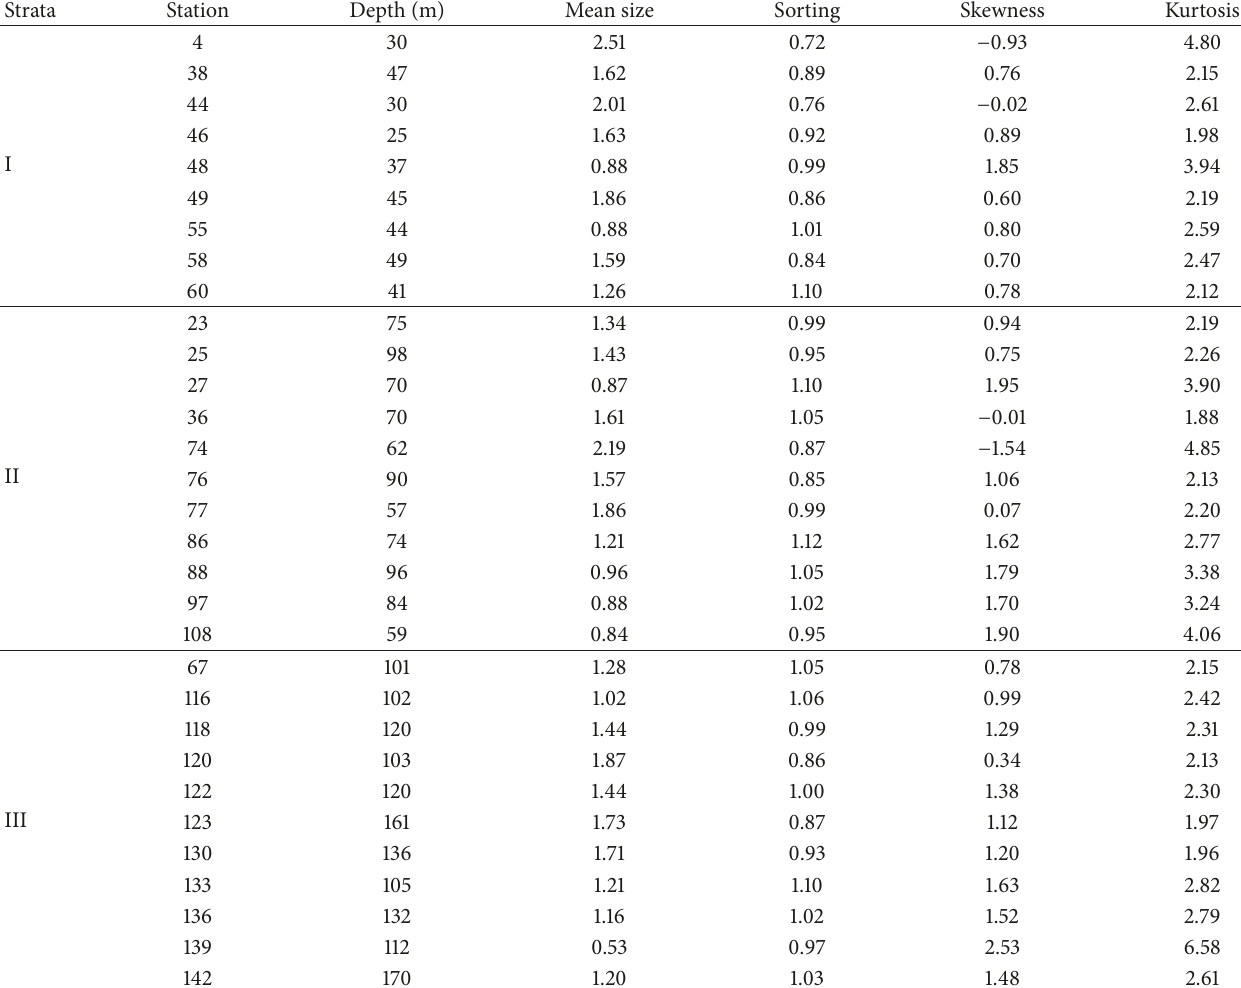
Table 2: Sand and silt/clay fraction distribution calculated using the method of moments statistical analysis.